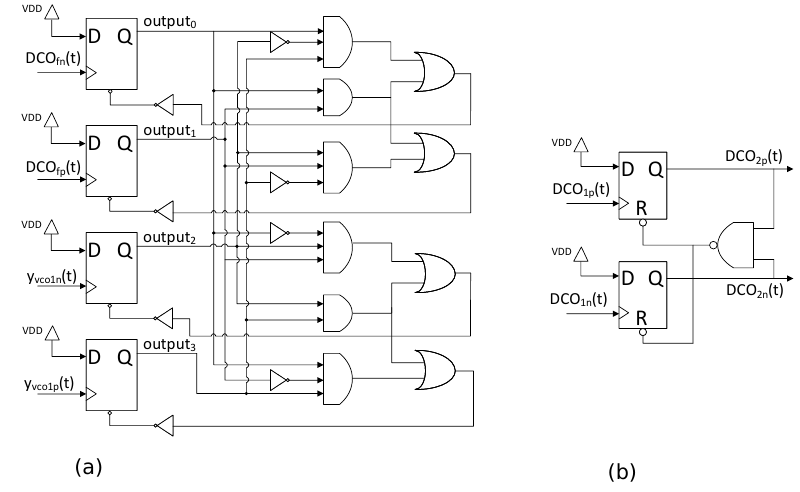
Figure 9. Asynchronous counters: ( a ) 4-bit counter; and ( b ) 2-bit counter.